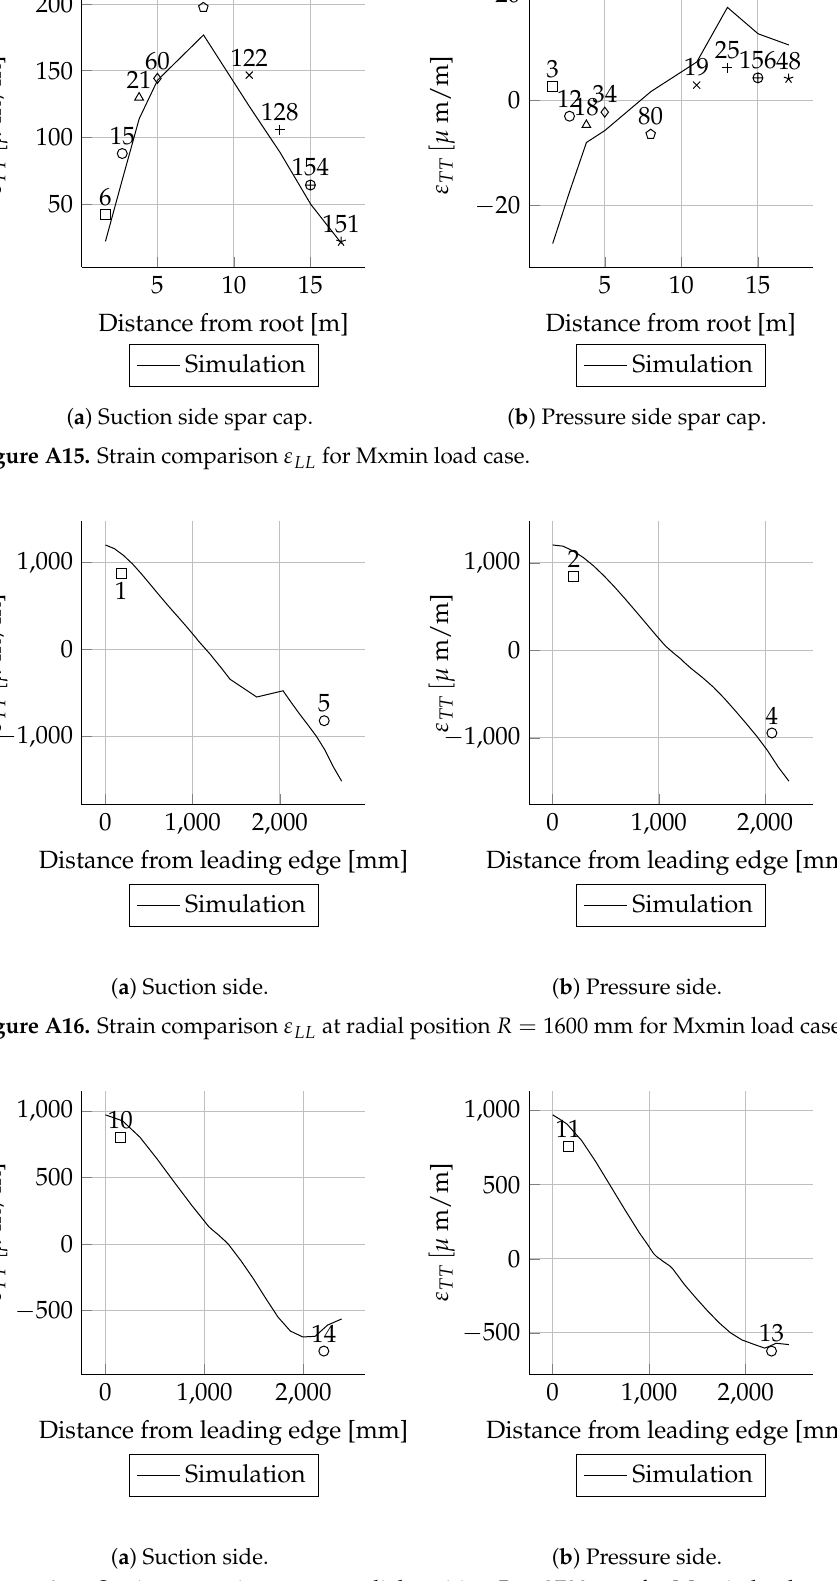
Figure A17. Strain comparison ε LL at radial position R = 2700 mm for Mxmin load